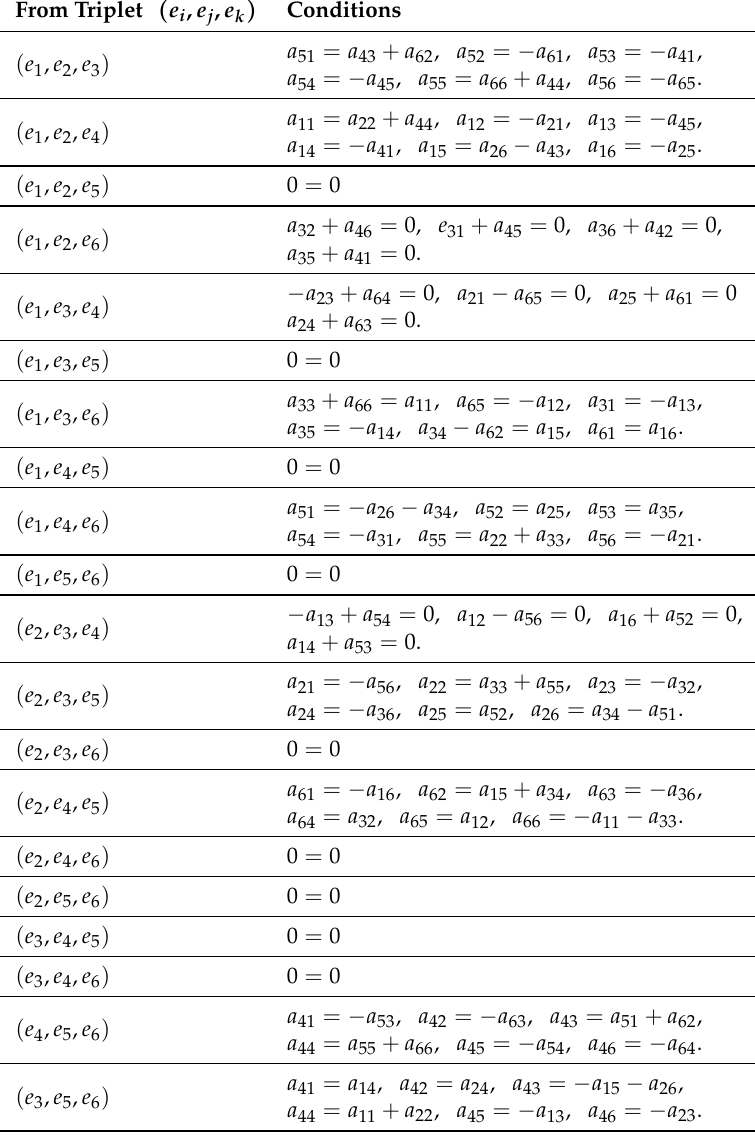
Table 3. Conditions